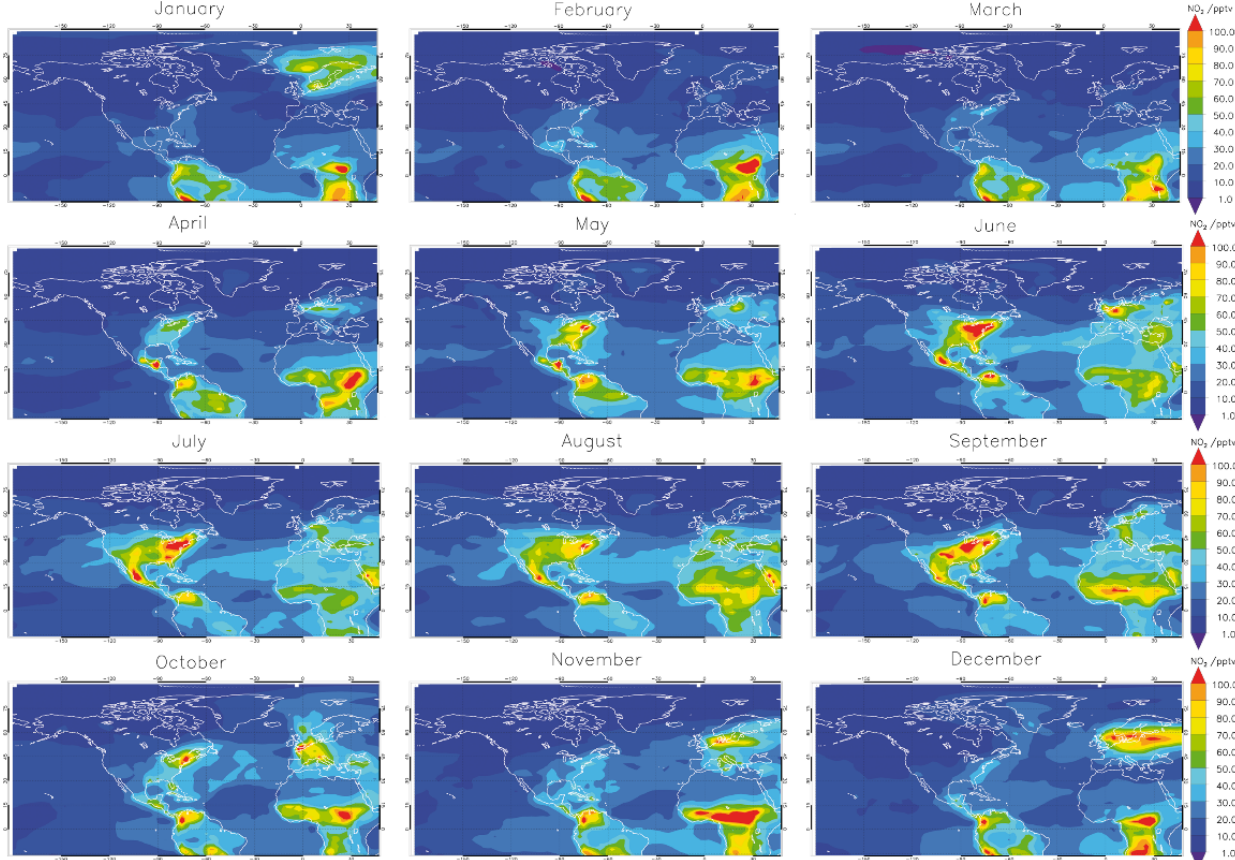
Figure 8. Global distributions of monthly mean NO 2 vmr for the level 5.9km, obtained from the CAM-Chem chemistry–climate model.